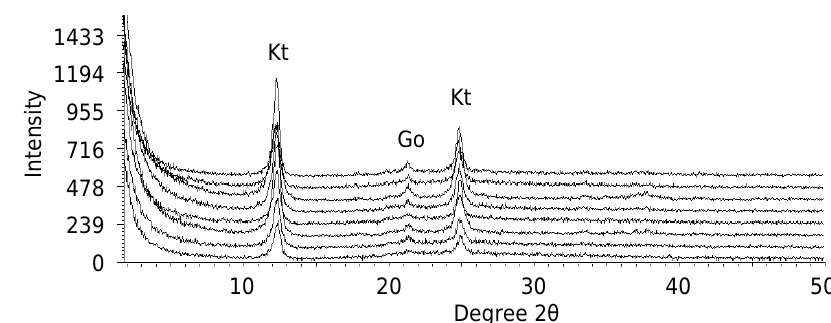
Soil micromorphology Microstructures in the Bt horizons were mostly angular and subangular blocky with accommodated planar voids (Table 6; Figure 5, blue arrows). Those in the Bw horizons were blocky and granular, with a compound packing void system (Table 6; Figure 6,